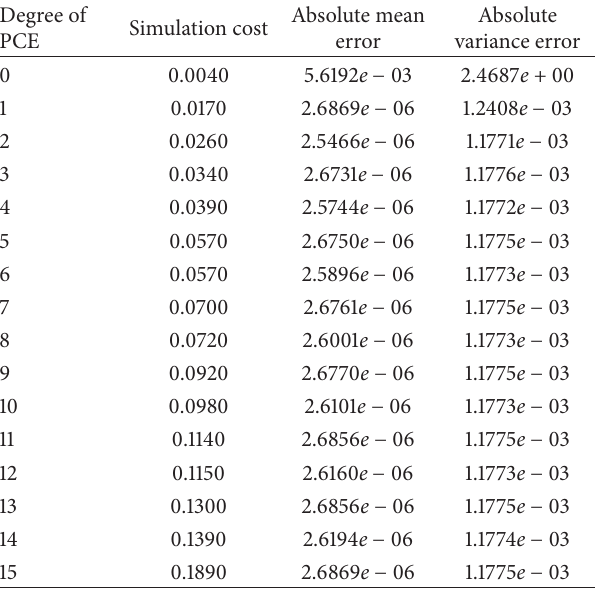
Table 18: Computational time costs and absolute error of mean and variance for PCE approximation of CIR interest rate model evaluated at 𝑇 = 1 , whose parameters are 𝛼 = 0.1 , 𝛽 = 0.002 , = 110 . 𝜎 = 15 %, and 𝑅 0